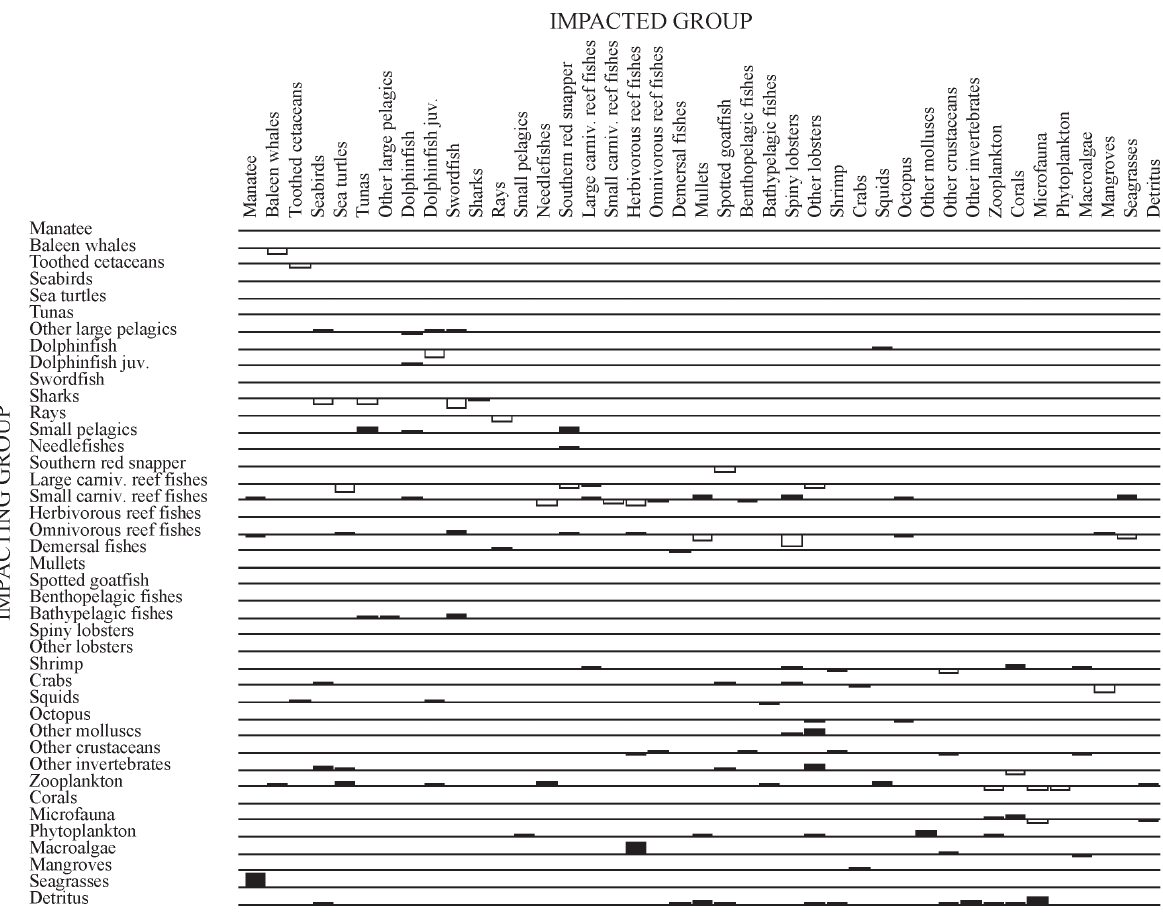
Fig . 2. – Mixed trophic impact in the northeastern Brazil marine ecosystem for the 1970s sensu Leontief (1951), calculated as how much a prey i contributes to the diet of a predator j minus the proportion of the predation on j due to predator i . The impact in each group is positive when placed above the line and negative when